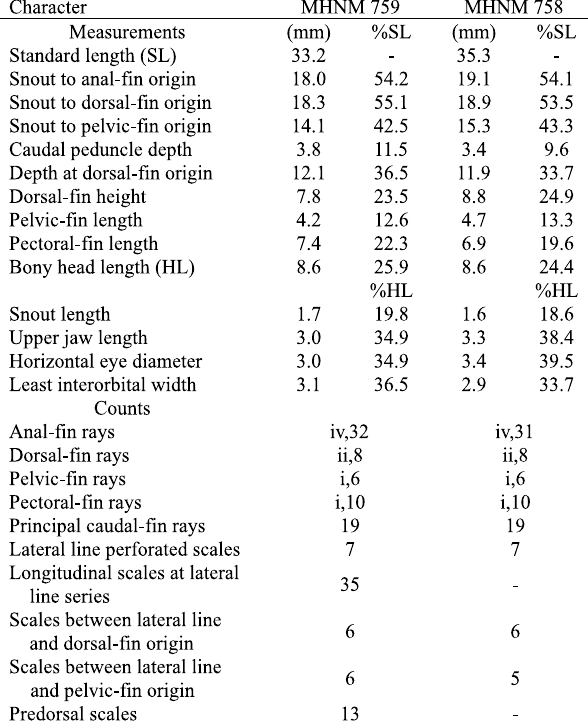
Table 1. Morphometric and meristic data of the two syntypes of Hyphessobrycon melanopleura uruguayensis Messner,